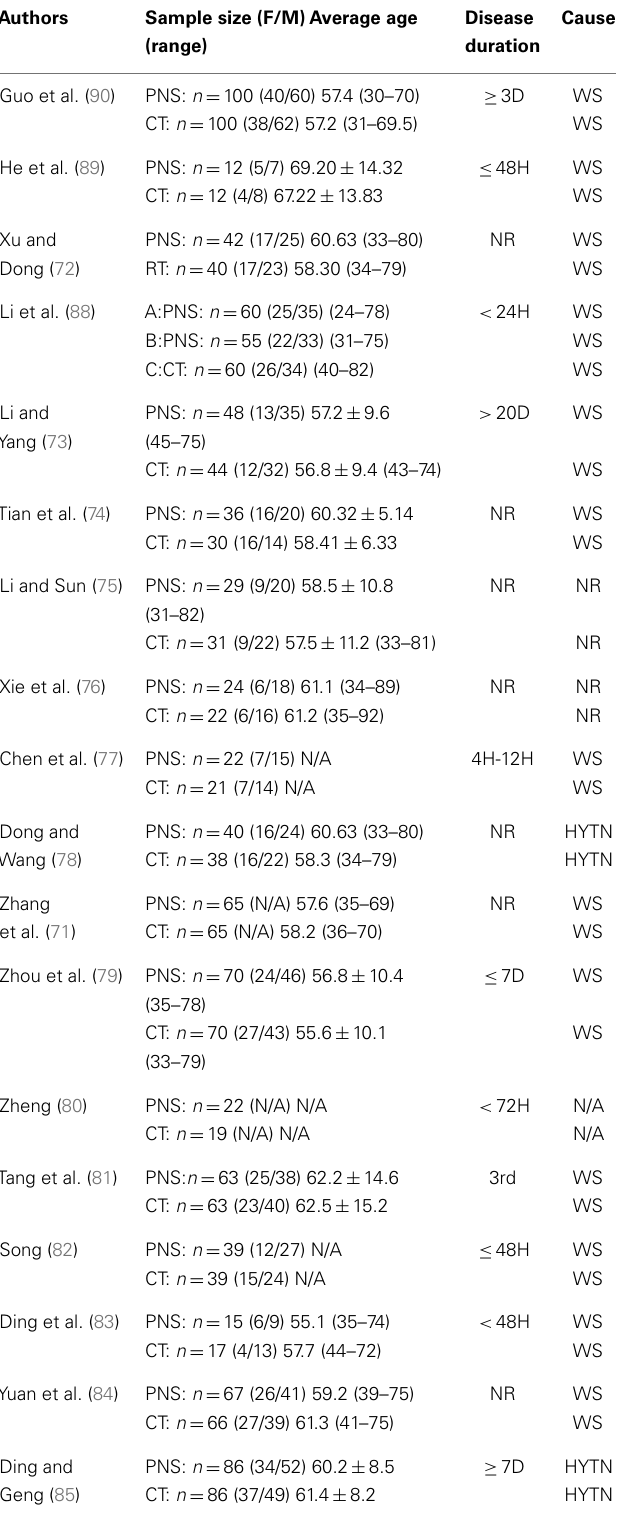
Table 1 | Baseline characteristics of each trial used in the meta-analysis .